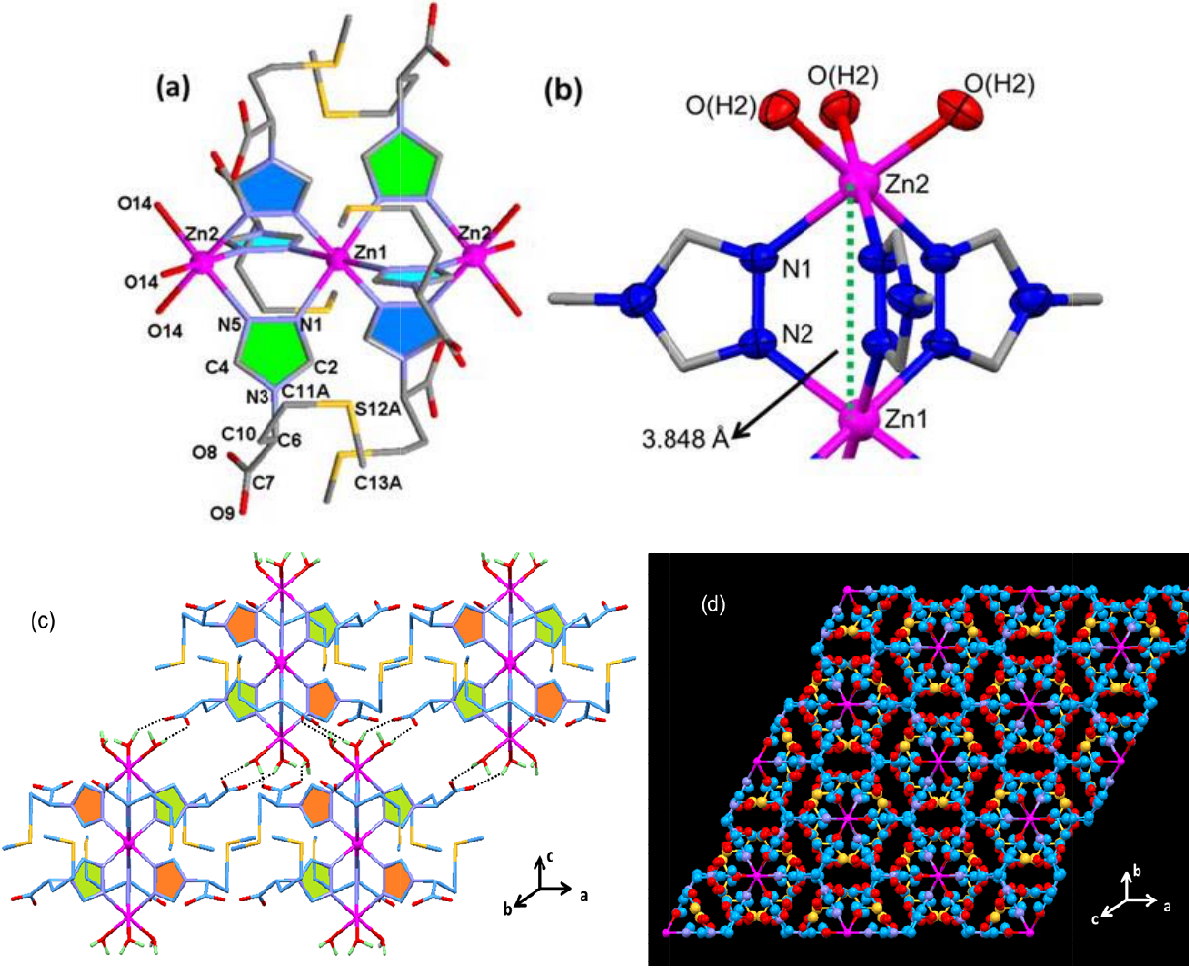
( b ) En binucl line) n